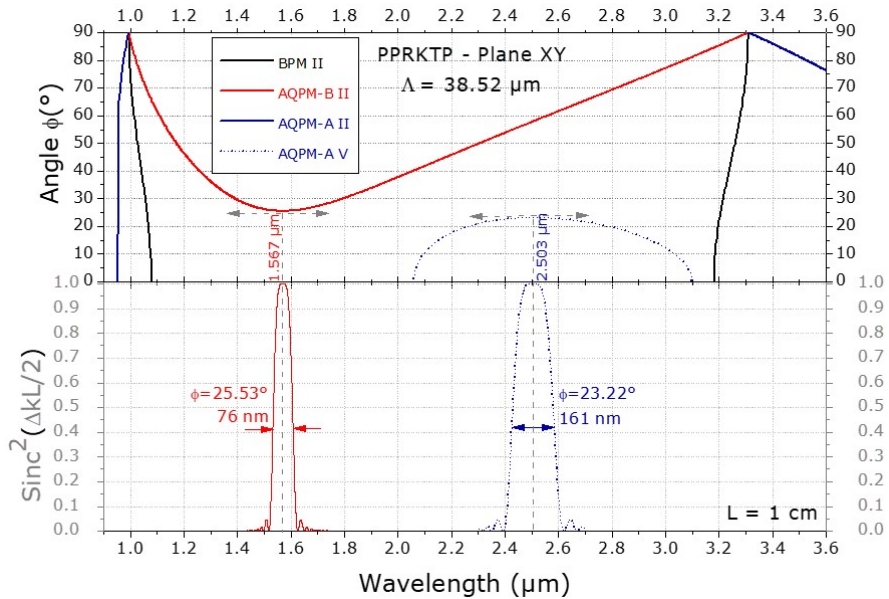
Figure 12. ( Top ) AQPM angle φ versus fundamental wavelength λω for SHG in the xy-plane of the PPRKTP with the poling period Λ = 38.52 µm: Type II BPM (full blackline); Type II AQPM-A and Type II AQPM-B (blue and red lines, respectively); Type V AQPM-A (grey dashed line). ( Bottom ) Spectral dependence of the sinc 2 ( ∆ kL /2) interference function for a crystal length L = 1 cm under the Undepleted Pump Approximation (UPA) and at the spectral noncritical wavelengths λω = 1.657 µm for Type II AQPM-B SHG (blue line) and λω = 2.503 µm for Type V AQPM-A (red line).